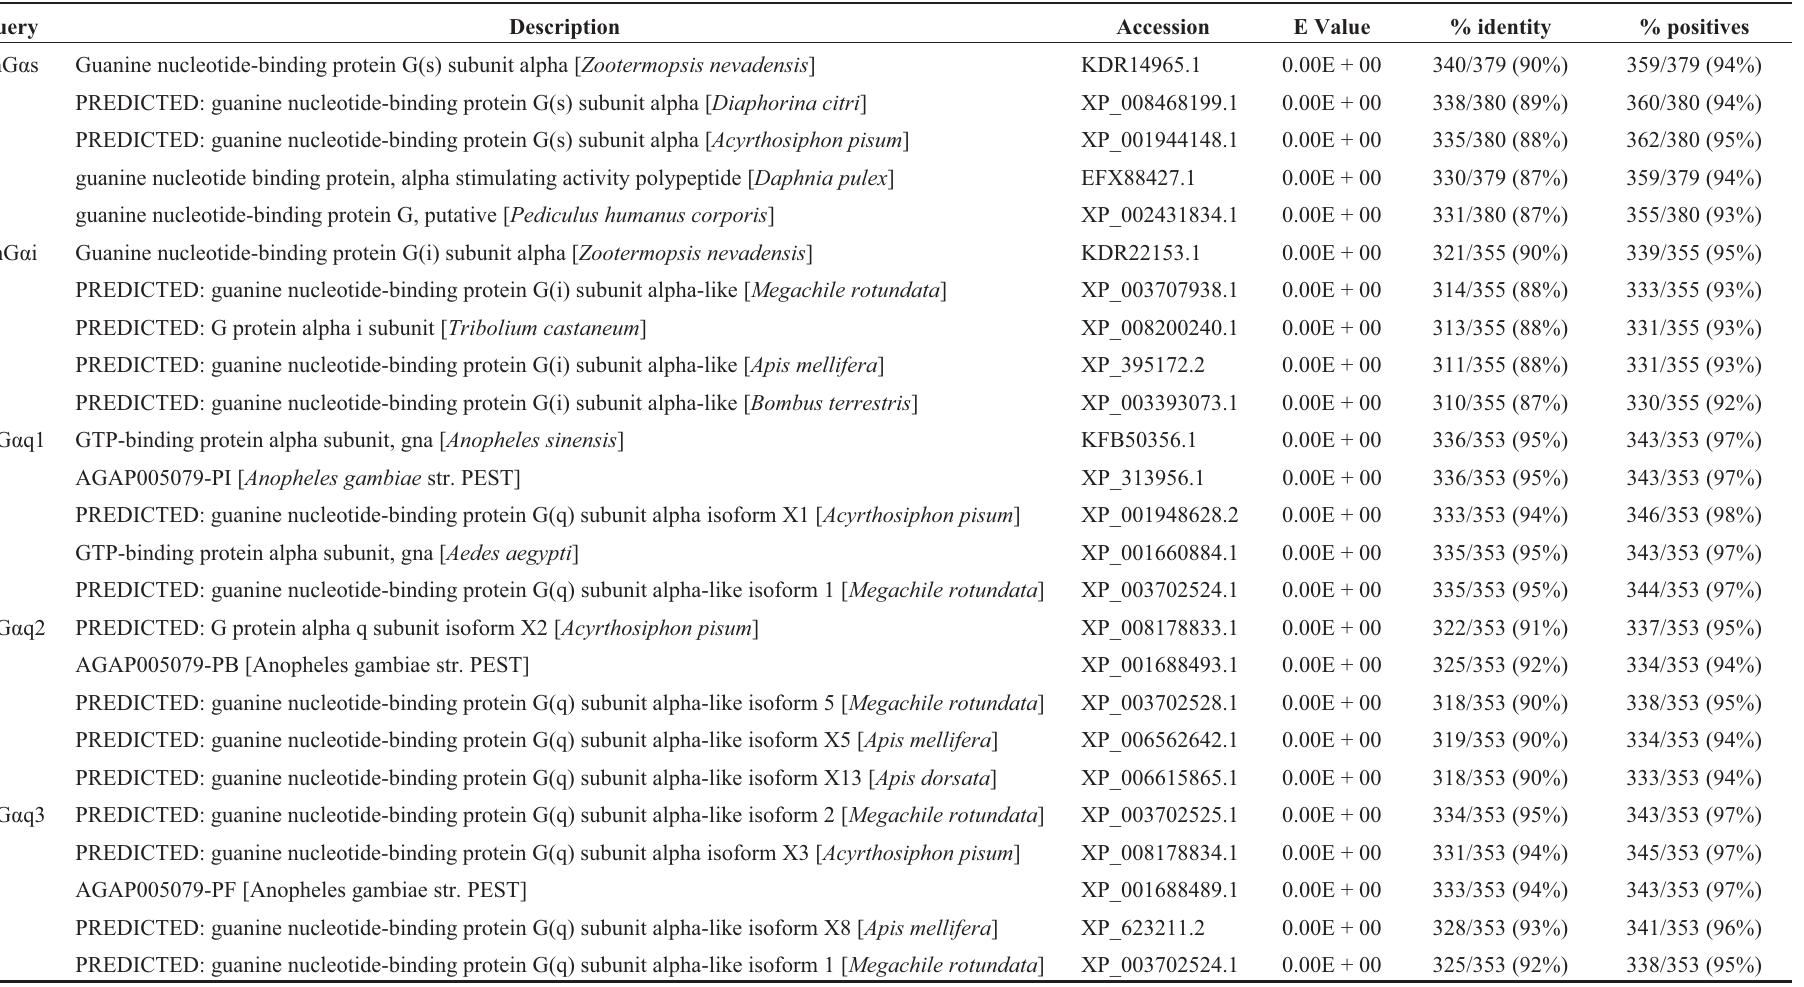
Table 2. Top five BLASTx hits for LhG(cid:2)